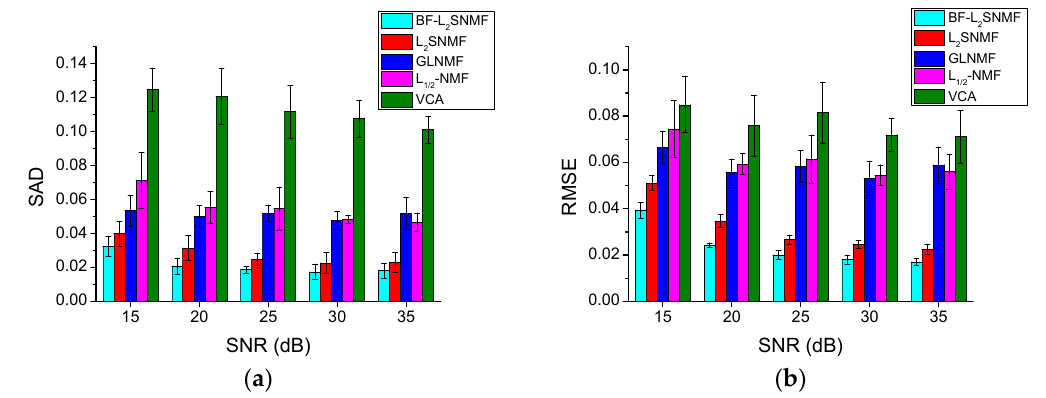
Figure 4. The experimental results for different noise levels: ( a ) SAD and ( b ) RMSE.